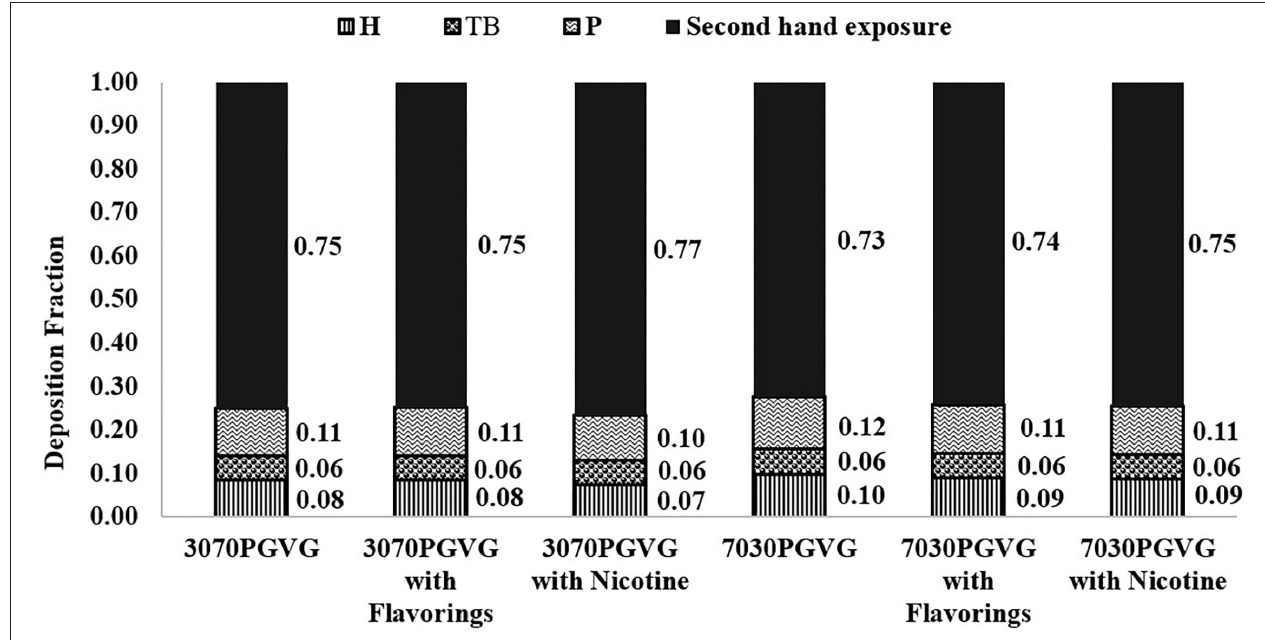
FIGURE 4 | Regional and total aerosol deposition in e-cigarette users and exhaled fraction by e-liquid (low-flow cascade impactor data). H, head region; TB, tracheobronchial region; P, pulmonary region; PG, propylene glycol; VG, vegetable glycerin.